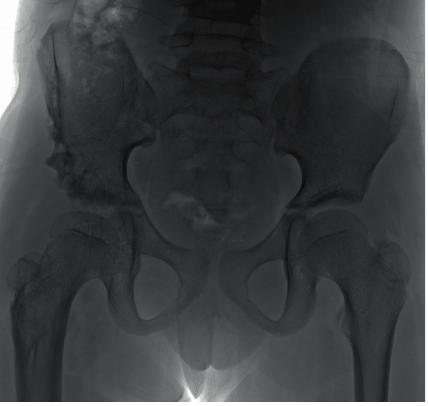
Figure 5: Control plain radiograph, five years after